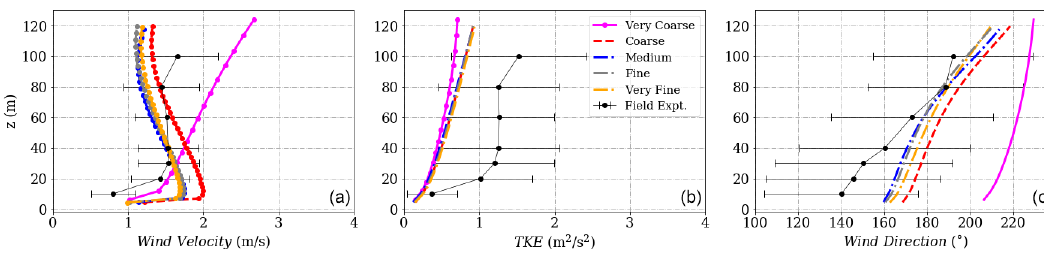
Figure A2. (a) Wind velocity magnitude, (b) wind direction and (c) turbulent kinetic energy at Tower 25 (tse09).